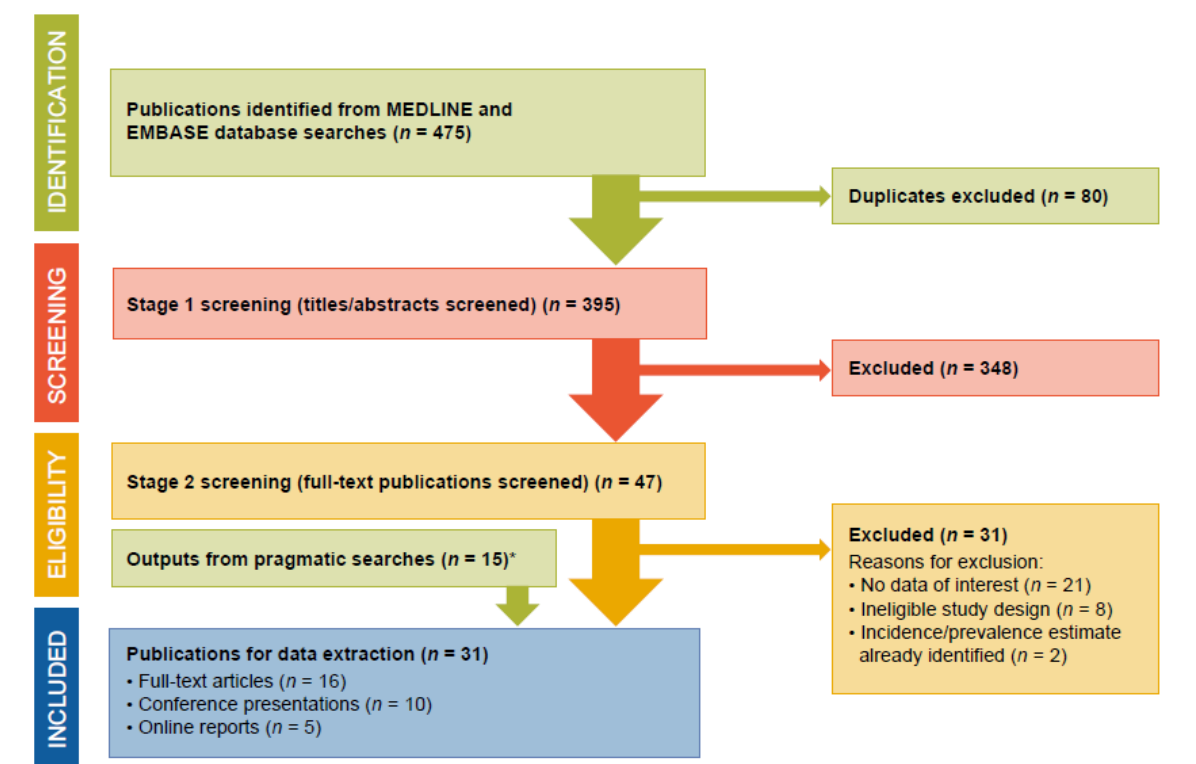
Figure 1. PRISMA flow chart. * Pragmatic searches yielded 13 web-based sources and two additional outputs identified from snowballing search methodology (referring to the use of reference lists or citations from identified sources to find additional sources). PRISMA, Preferred Reporting Items for Systematic Reviews and Meta-Analyses.